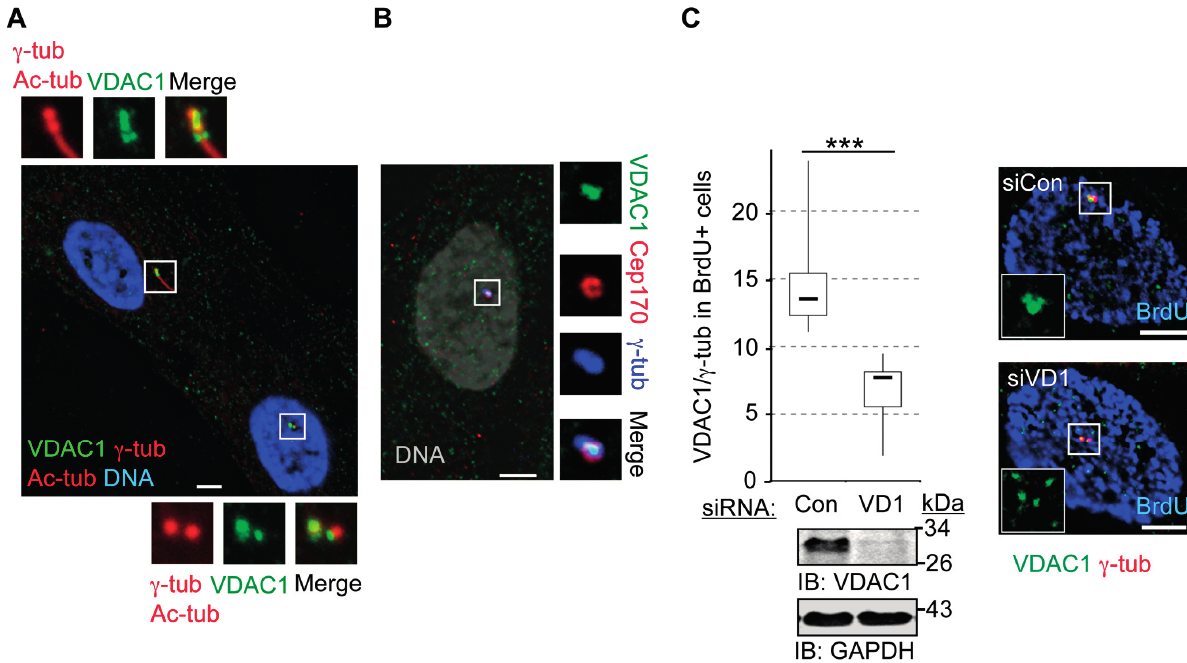
Figure 3. VDAC1 is more strongly associated with mother centriole. ( A – B ) Representative images of asynchronous RPE1 cells stained for VDAC1 (green), and ( A ) γ -tubulin ( γ -tub; red) and Ac-tubulin (Ac-tub; red); ( B ) Cep170 (red) and γ -tub (blue). Ac-Tub stained centriolar microtubules and primary cilia. DNA is blue in ( A ) and grey in ( B ). Bar = 5 μ m. ( C ) Asynchronously growing RPE1 cells treated with siRNAs against Lamin A/C (siCon) and VDAC1 (siVD1) for 72 h. Cells were labeled with BrdU, and stained for VDAC1 (green) and γ -tub (red). The box and whisker diagram shows the normalized fluorescence intensity values of centrosomal VDAC1 from twenty five cells, where boxes represent lower and upper quartiles, the marker in the box (-) indicates the median, and the whiskers represent minimum and maximum values. p value is derived from unpaired t -test. *** indicates p < 0.0005. Representative immunoblots at the bottom of the graph show depletion (roughly 80%) of whole-cell VDAC1 in siVDAC1 cells compared to control cells, where GAPDH is loading control. Molecular weight standards (kDa) are shown next to the immunoblots. Micrographs show representative siCon and siVDAC1 cells stained for VDAC1, γ -tub and BrdU (blue), Bar = 5 μ